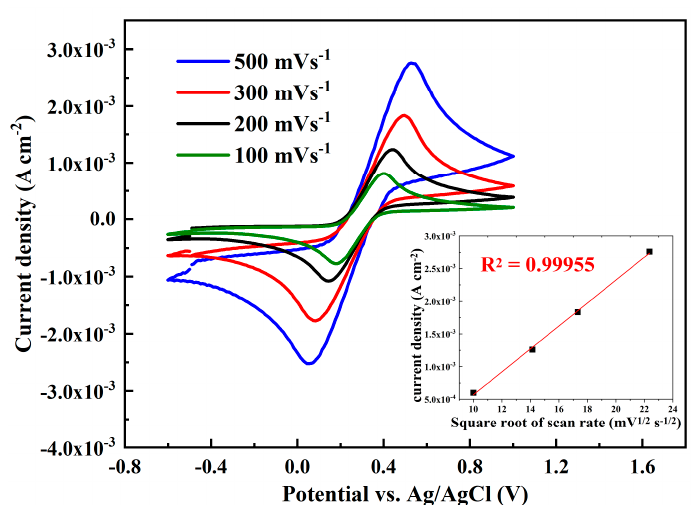
Figure 4. Cyclic voltammetry of the graphene-modified electrode as a function of the scan rate. Inset: anodic currents linear dependence on the square root of the sweep rate ( ν 1/2 ). All experiments are recorded in 0.1 M KCl solution containing 5 mM K 3 [Fe(CN) 6 ]/K 4 [Fe(CN) 6 ].